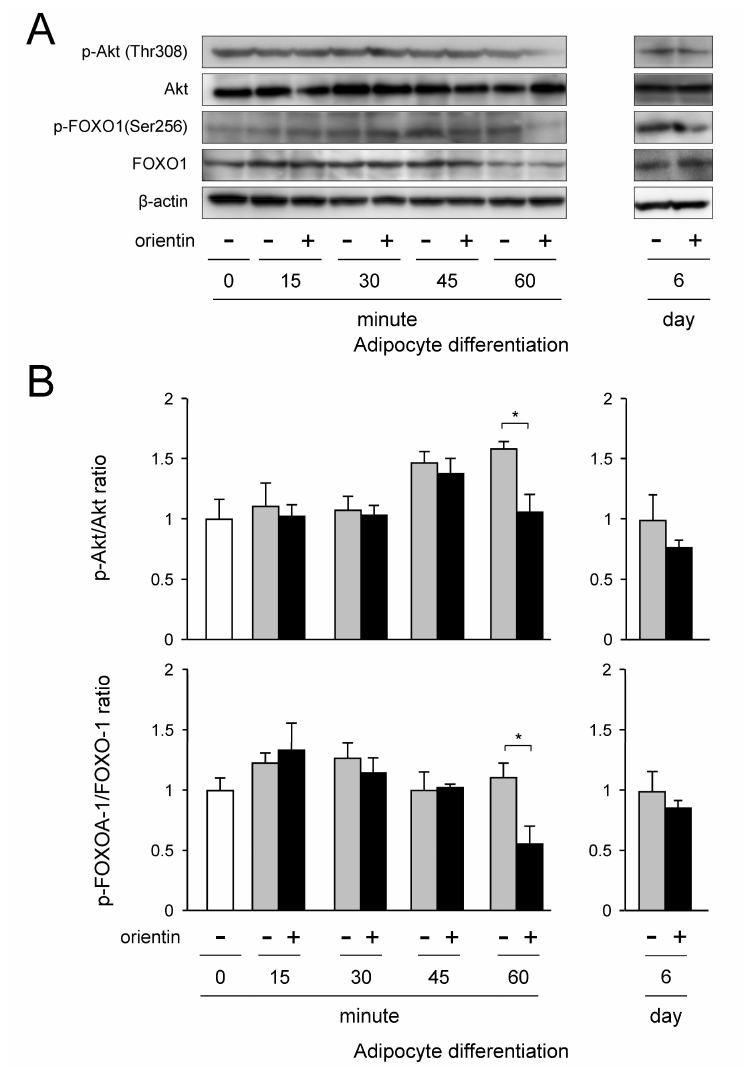
Figure 6. Reduced phosphorylation of Akt and FOXO1 by orientin in early stage of adipogenesis. ( A ) Western blot analysis. 3T3-L1 cells were differentiated into adipocytes for the indicated time periods in medium with orientin (0 or 50 µ M). For Western blot analysis, 15 µ g protein was loaded in each lane. Data are the representative of three experiments; ( B ) Ratio of p-Akt/Akt and p-FOXO1/FOXO1 levels. The expression levels shown in Figure 6A were measured. Before calculation of ratio, each band intensity was normalized with that of β -actin. Data are shown as the means ± S.D. from three experiments. * p < 0.01, as shown by the